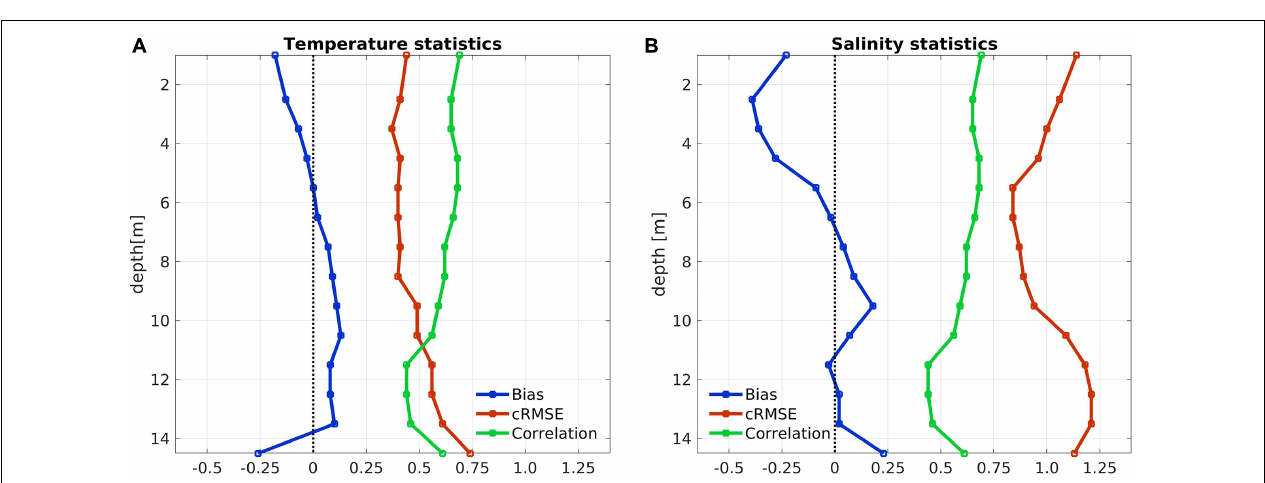
FIGURE 7 | Bias (A,C) and cRMSE (B,D) of modeled water salinity at surface (upper panel, A,B ) and 4.5–5 m depth (lower panel, C,D ) in the Limfjord. Each marker represents a station with at least 10 observations.